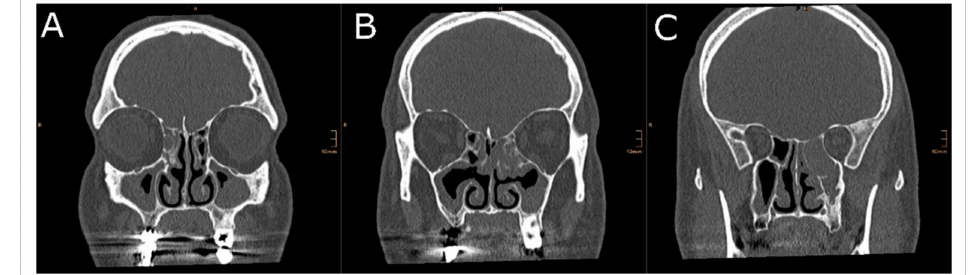
Figure 2. Two-dimensional cross-sectional analysis of the OC-cleft opacification in a patient with non-eosinophilic chronic rhinosinusitis. This patient had a TDI score of 29.5 at the right nostril, while olfactory testing of the left side revealed a TDI score of 22. The left side of the picture is the right side of the patient. ( A ) Anterior section, ( B ) middle section, and ( C ) posterior section. Table 1. Demographic, olfactory, and radiologic characteristics. Data are presented as mean